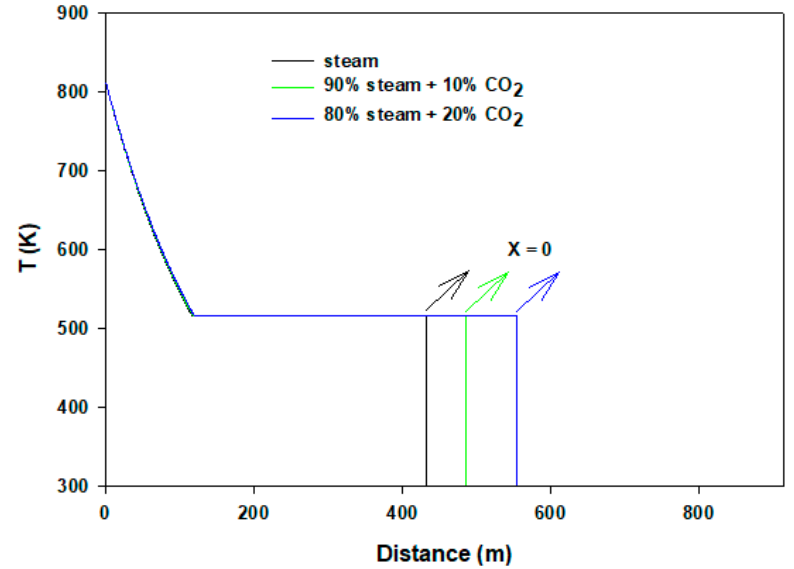
Figure 5. Temperature profiles of horizontal flows.